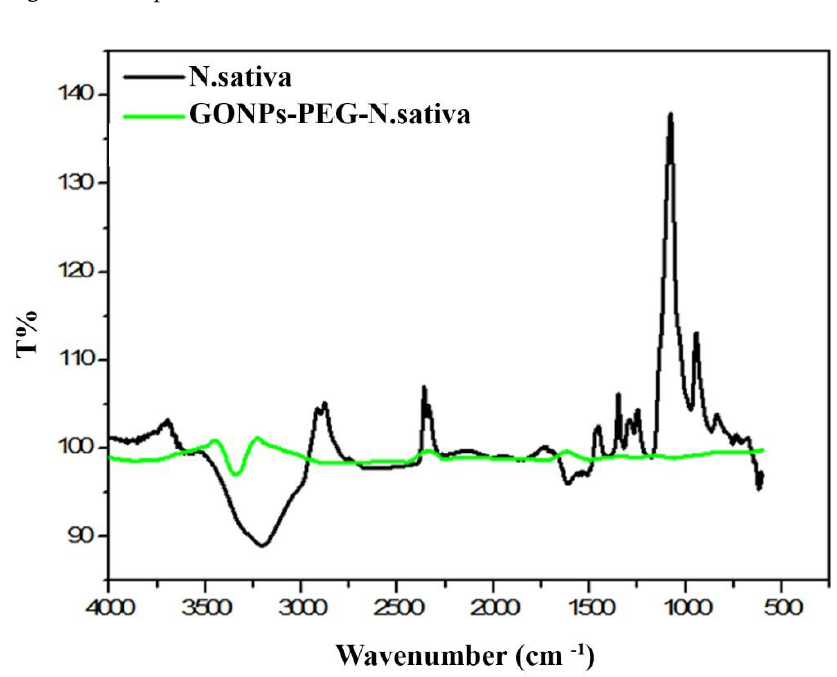
Figure 5. FTIR spectrum of N. sativa extract and GONPs-PEG- N. sativa.